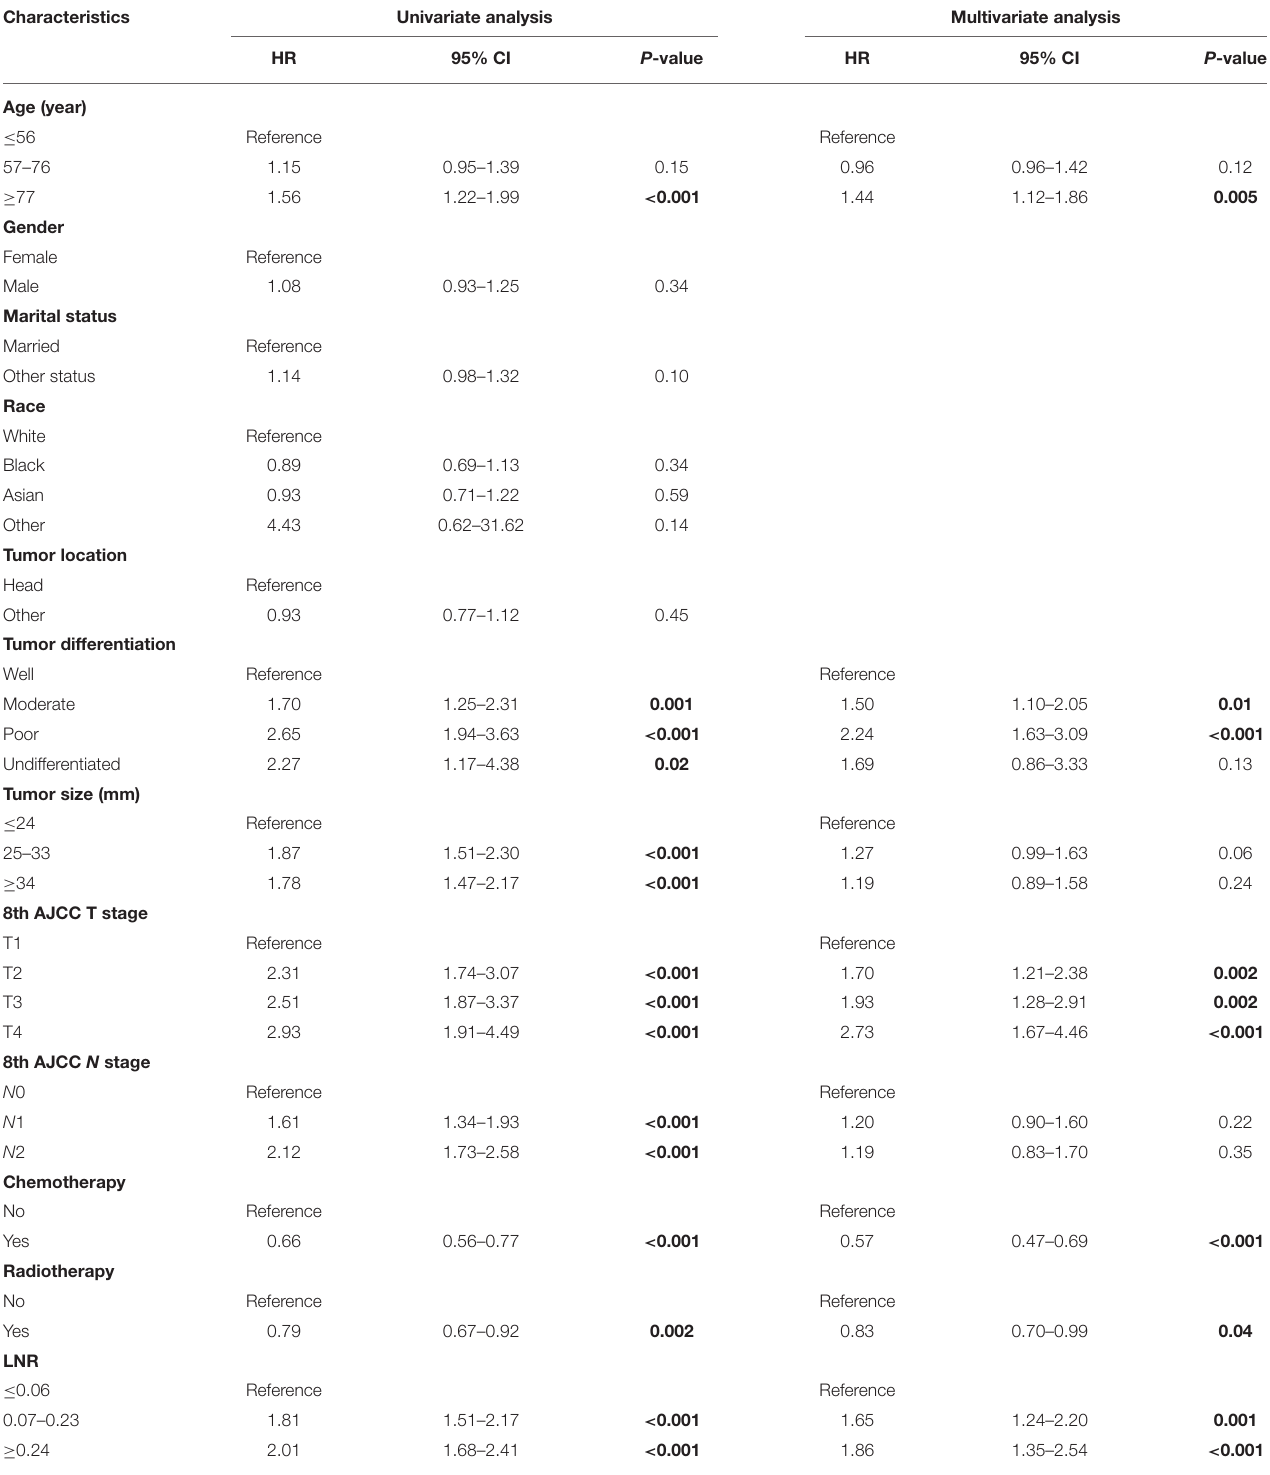
TABLE 2 | Univariate and multivariate Cox analysis of variables affecting OS for PDAC patients following TP.